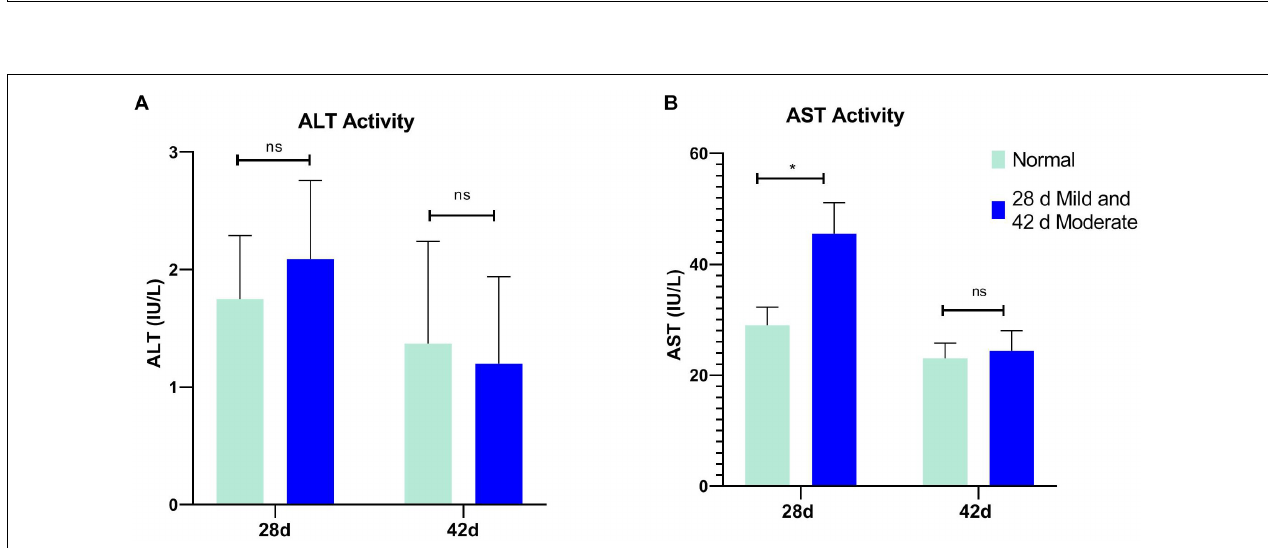
FIGURE 2 | Serum alanine transaminase (ALT) and aspartate transaminase (AST) activity at 28 ( n = 20 in total) and 42 days of age ( n = 49 in total). (A) ALT activity; (B) AST activity. * P < 0.05; ns, P > 0.05.